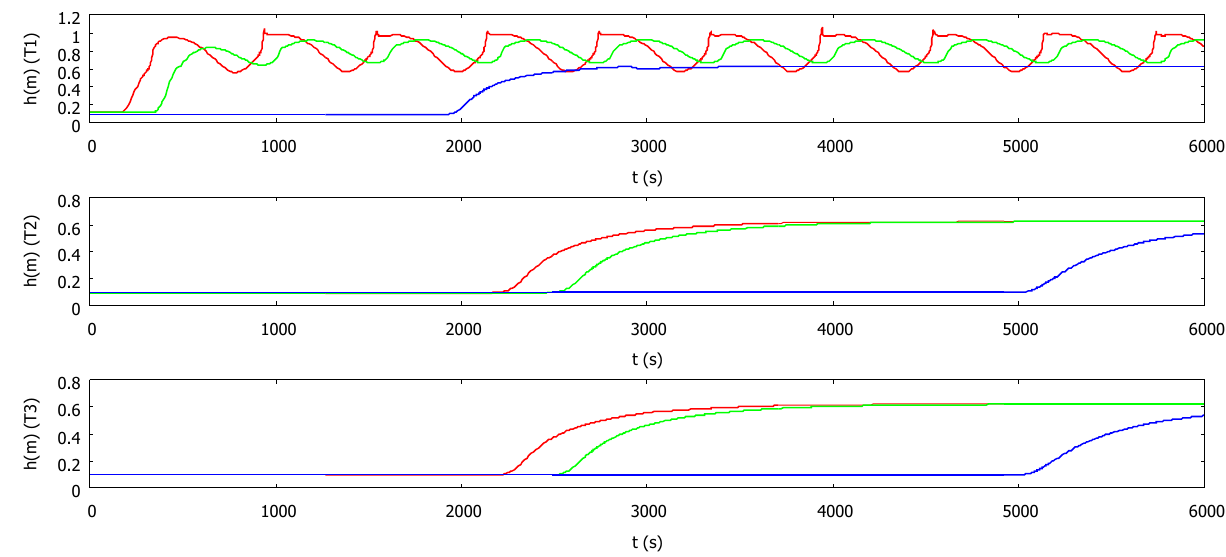
Figure 11. Triangular inlet hydrograph in the pipe 1.